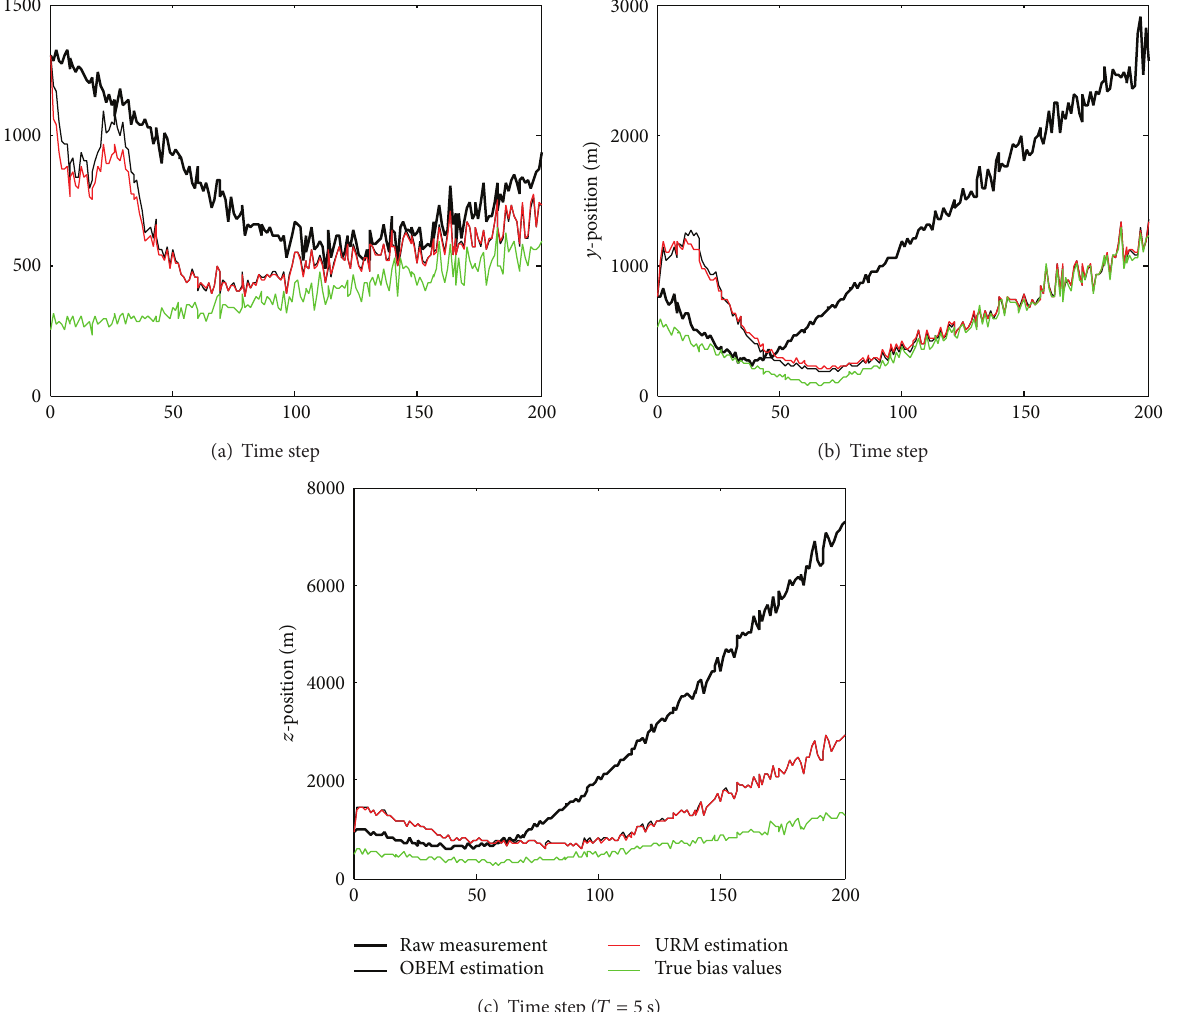
Figure 7: RMSE of the target location in xyz -coordinates after rectifying radar 1 measurements by BEs. (a) 𝑥 -coordinates; (b) 𝑦 -coordinates; (c) 𝑧